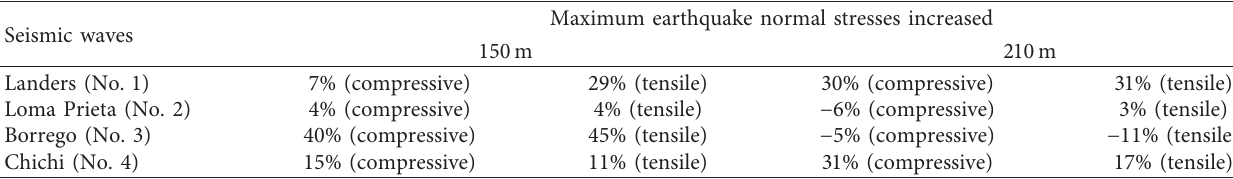
Table 4: Percentages of increase in maximum earthquake normal stresses.